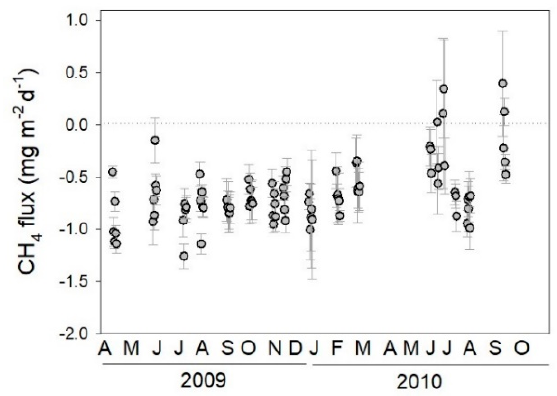
Figure 1. Average daily CH 4 fluxes ( ± 1 SE, n = 8) measured in the top-hill site of Ankasa Park from April 2009 to October 2010.